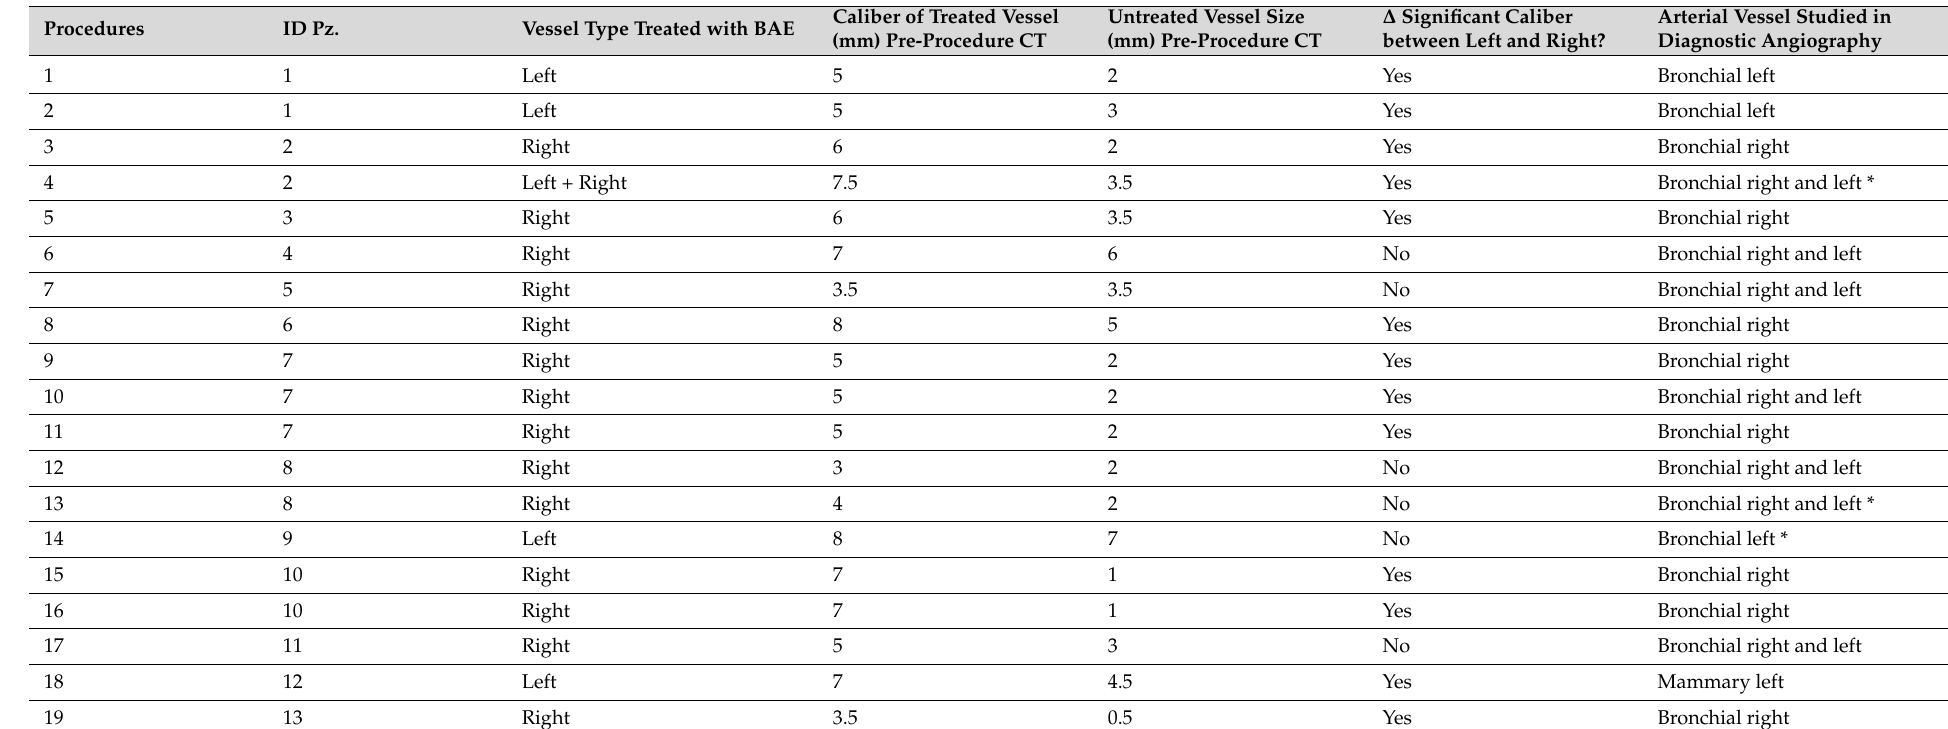
Table 2. Characteristics of the procedures of embolization (n =